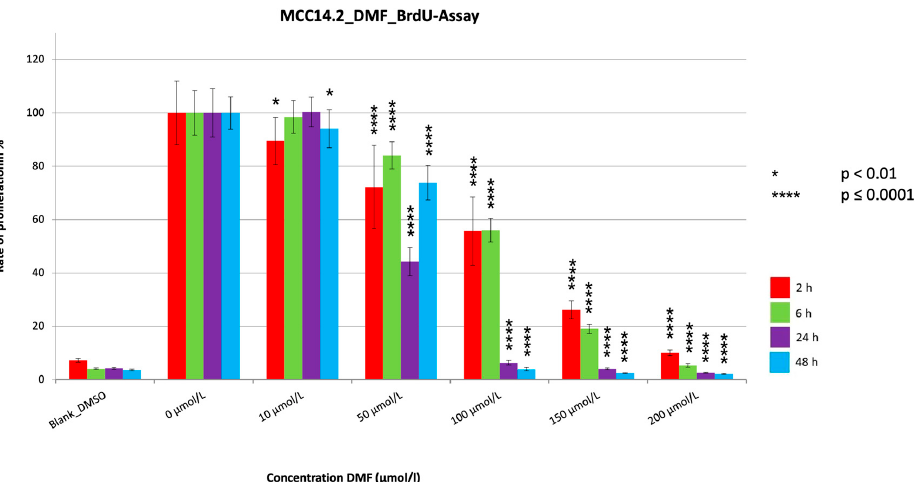
Figure 5. Cell proliferation measurements of the cell line MCC14.2 with a cell concentration of 20.000 cells/well with the addition of the substance DMF in different concentrations (10–200 µmol/L). Values are expressed as the mean ± SD of eight technical replicates. A multiple comparison test following the ANOVA was used to test whether there were significant differences between the individual mean values and the mean value of the normal control.